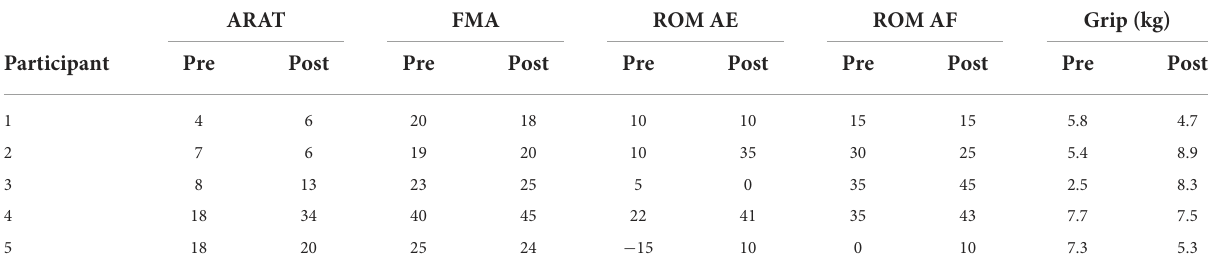
TABLE 2 Clinical assessment scores of 5 chronic stroke survivors before and after training with Tele-REINVENT. ARAT FMA ROM AE ROM AF